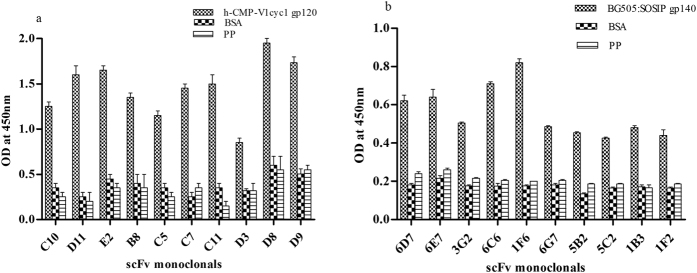
Phage ELISA binding with (a) h-CMP-V1cyc1 gp120 and (b) BG505:SOSIP.664. scFv clones exhibiting high binding to the h-CMP-V1cyc1 gp120 and BG505:SOSIP.664 were selected. ELISA plates were coated with h-CMP-V1cyc1 gp120, BSA and a peptide pool of unrelated viruses (negative controls). The experiment was repeated at least twice and the mean OD values are shown. Mean binding titres were compared with negative control.